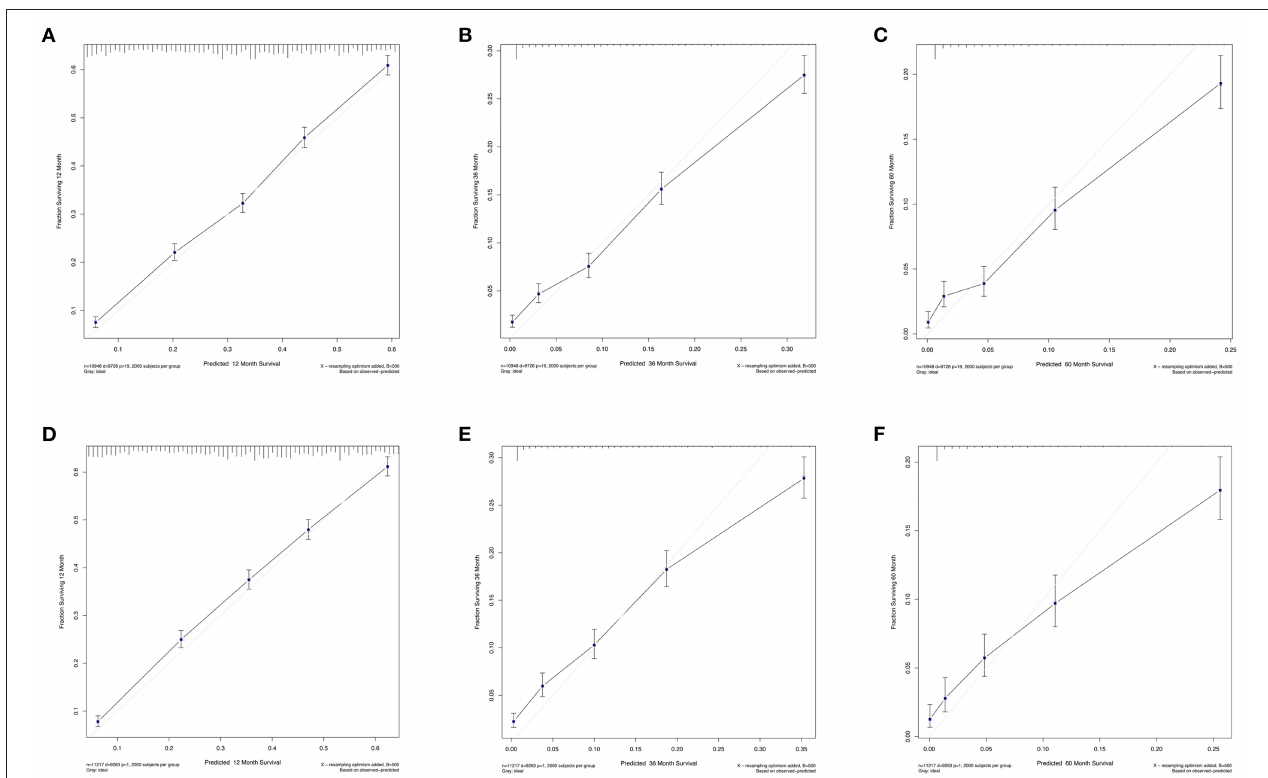
FIGURE 5 | Calibration curves for the nomogram model of predicting 1-year (A,D) , 3-year (B,E) , and 5-year (C,F) Lung CSS in patients with N3-NSCLC. (A–C) Internal validation using the training cohort. (D–F) External validation using the validation